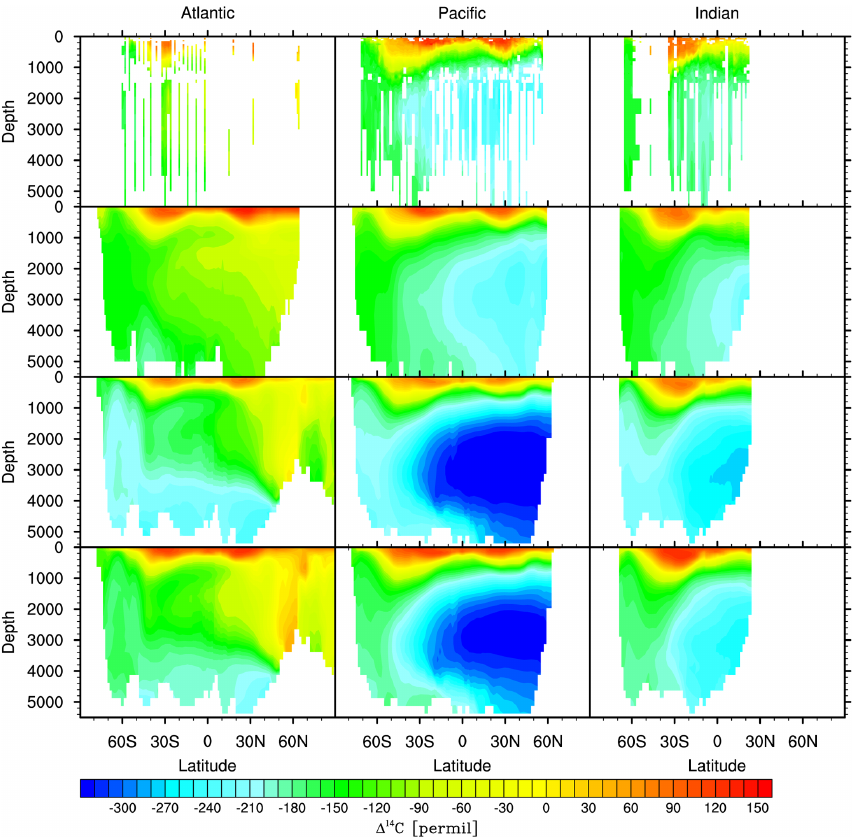
Figure 3. Zonal averages of total (cid:49) 14 C for the Atlantic, Pacific, and Indian oceans for the 1990s, from cruise data compiled by Schmittner et al. (2013) (top row), the gridded GLODAP data (Key et al., 2004) (second row), the (cid:49) 14 C from the biotic model (third row), and the abiotic model (bottom row). Note that due to the sparse observational data (see Fig. 2a for the coverage at the surface), the zonal average from the cruise data in the top row is more of a zonal composite than a zonal average.